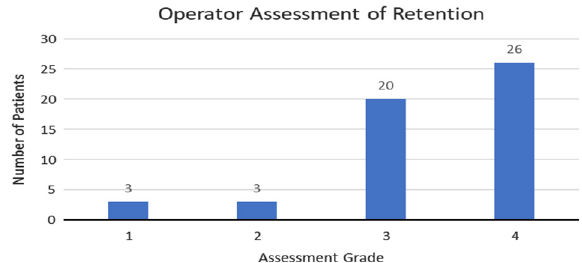
Figure 6. Operator assessment of retention.